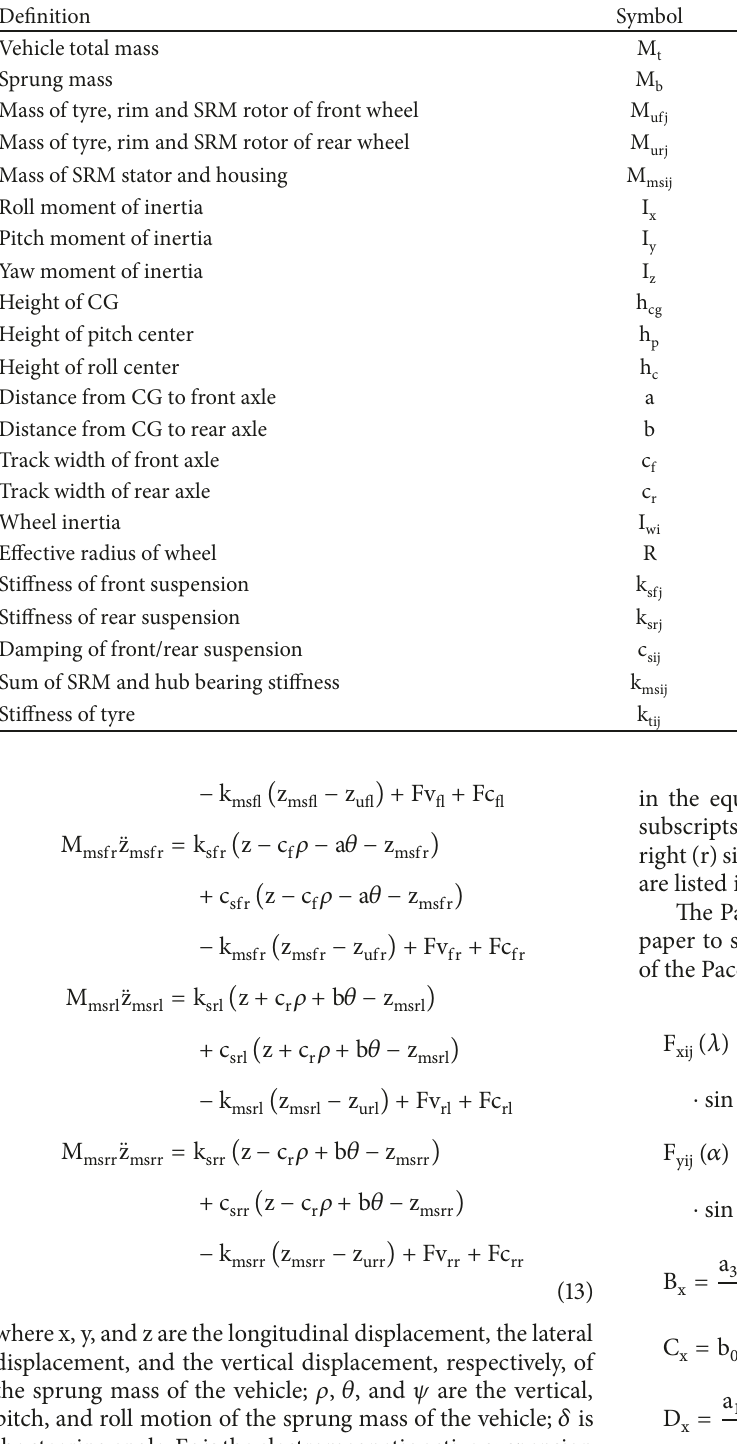
Table 2: The vehicle parameter